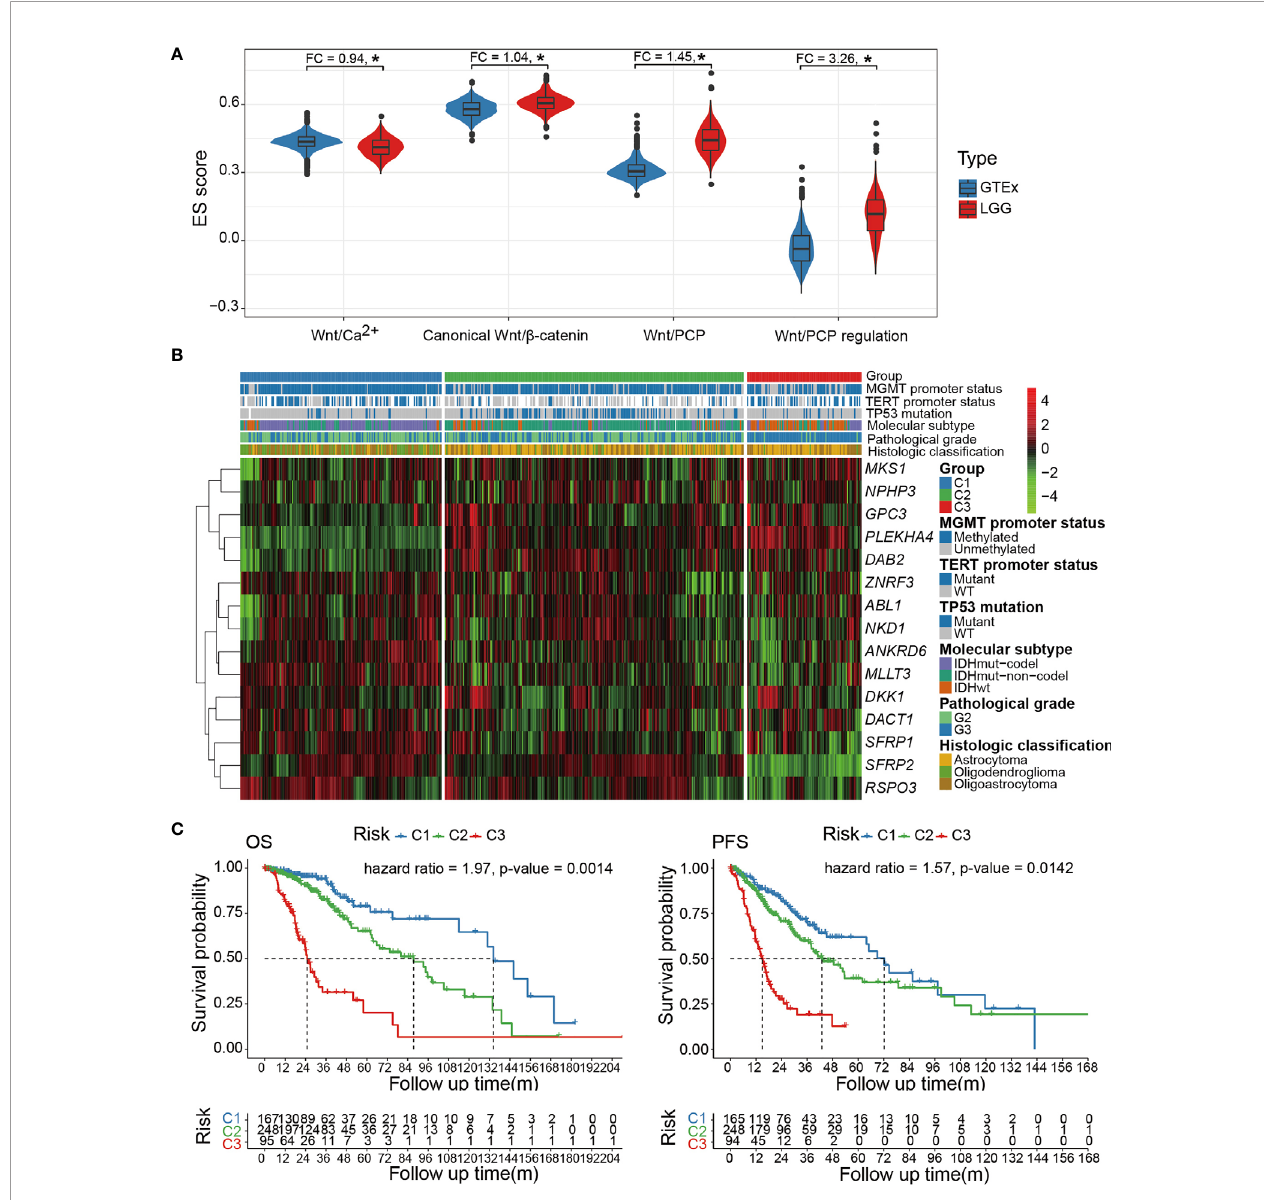
FIGURE 1 | (A) Comparison of pathway enrichment for each of the four Wnt pathway branches (Wnt/ b -catenin, Wnt/Ca 2+ , Wnt/PCP, and Wnt/PCP regulation). (B) The expression spectrum of the Wnt/PCP regulation pathway categorizes three LGG subtypes with distinct molecular characteristics as well as differentiated prognosis. (C) Cox proportional-hazard model indicated that the Wnt/PCP regulation pathway can independently predict survival of LGG patients. *P <